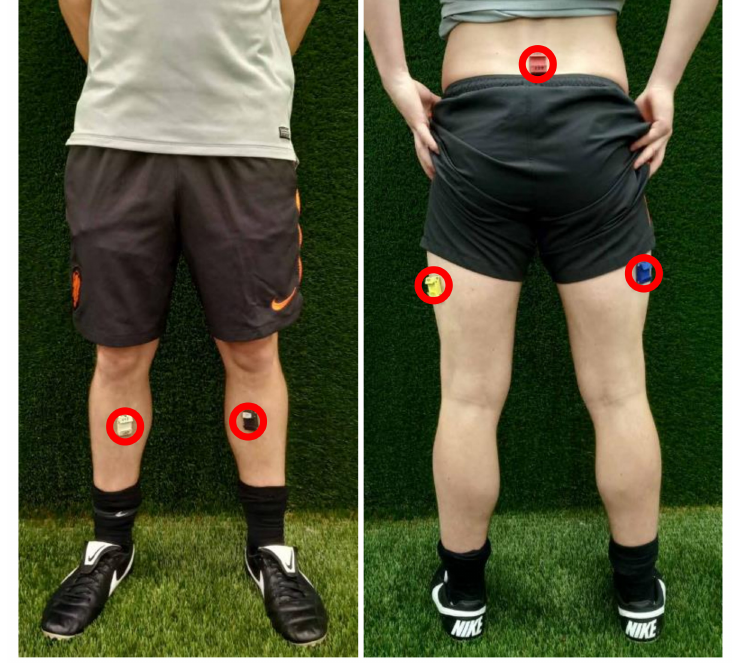
Figure 1. Sensor placement. The sensors were placed at the sacrum, iliotibial tracts, and shins. For clarity, the covering adhesive plaster was left out of the